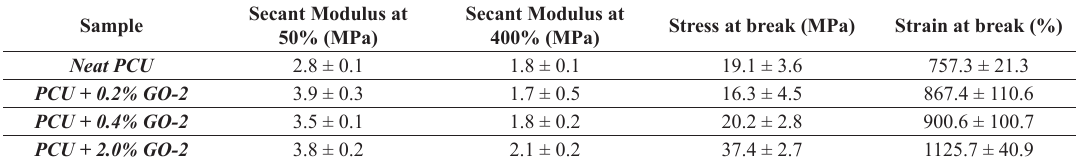
Table 4. Mechanical properties for neat PCU and its nanocomposites.